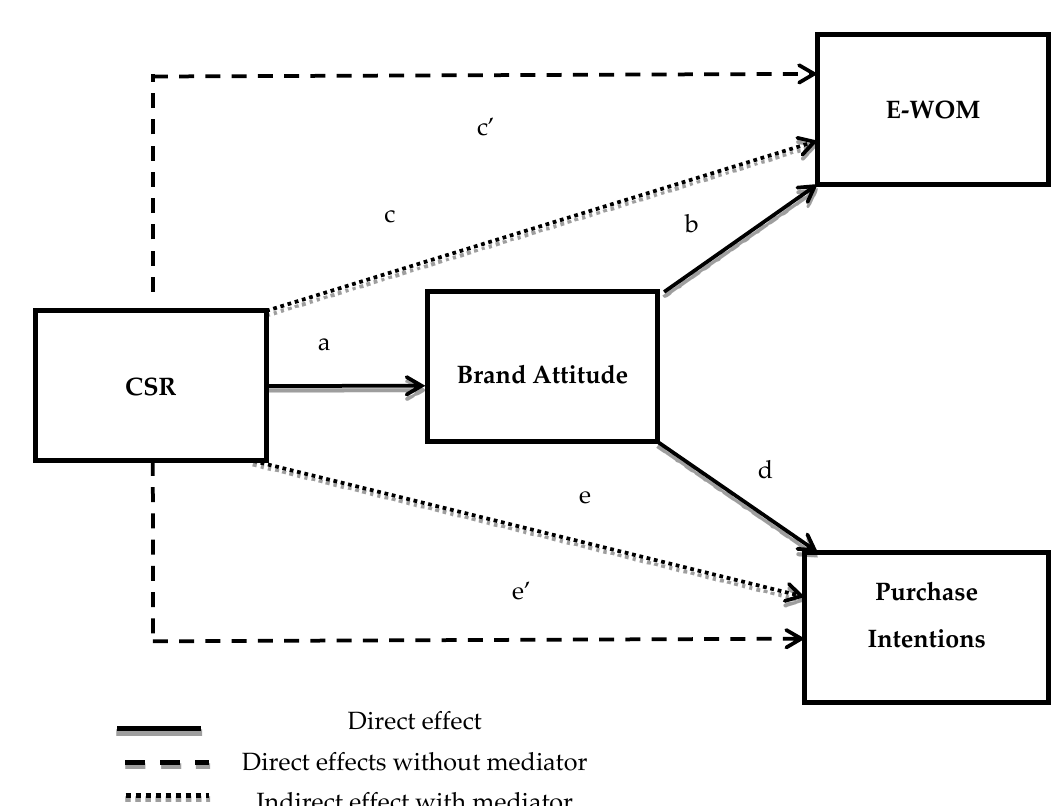
Figure 1. Proposed research model: Customer-related CSR activities on social media (X) = the independent variable, purchase intention (Y) = the dependent variable, E-WOM (Y) = the dependent variable, brand attitude (M) = the mediating variable, a × b = the indirect effect of the mediator on Y, a × d = the indirect effect of the mediator on Y, c’ =direct effect of X on Y without the effect of the mediator, e’ = direct effect of X on Y without the effect of the mediator, c= indirect effect of X on Y with mediator, e = direct effect of X on Y with mediator.